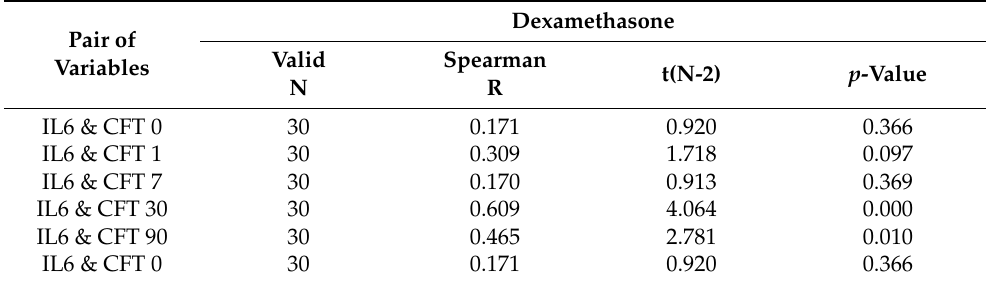
Table 2. Correlation between IL-6 levels (pg/mL) and change in CFT values ( µ m) in the group treated with dexamethasone.